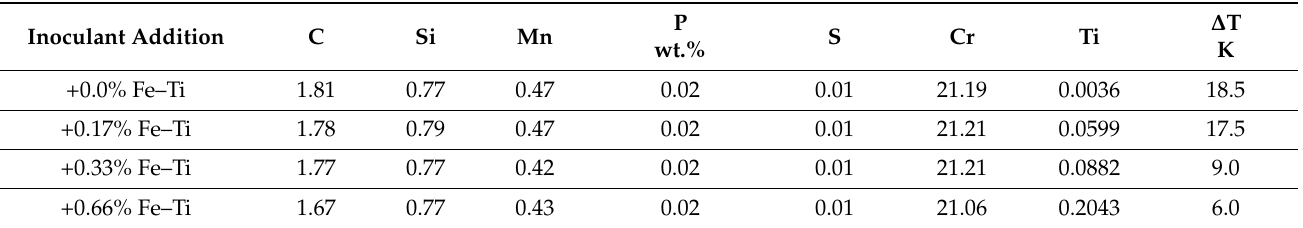
Table 1. Chemical composition of chromium cast iron and values of degrees of supercooling ∆ T for crystallisation of primary